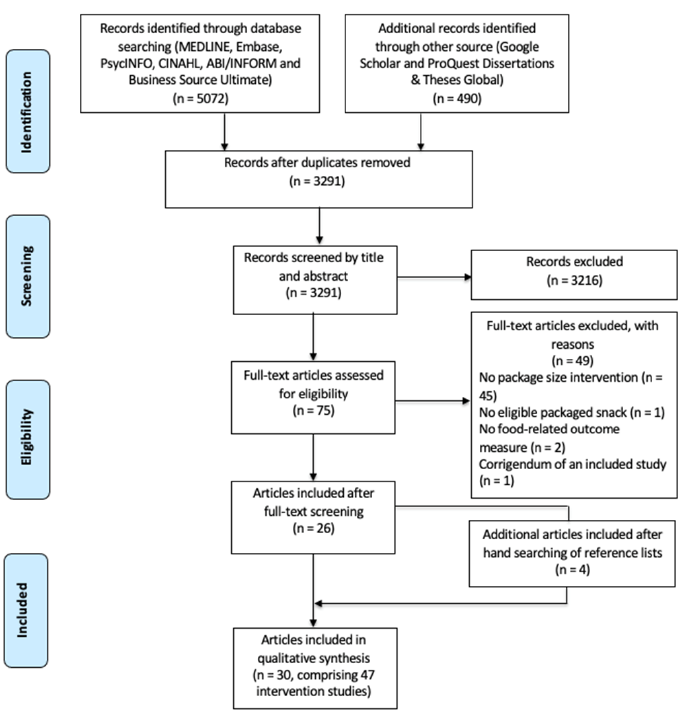
Figure 1. Preferred reporting items for systematic reviews and meta-analyses for the scoping review process (PRISMA-ScR) flow